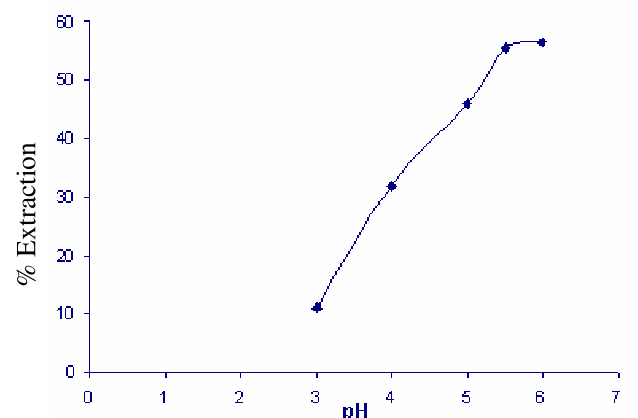
Figure 2. The effect of pH on the extraction of MTTT-copper complex.